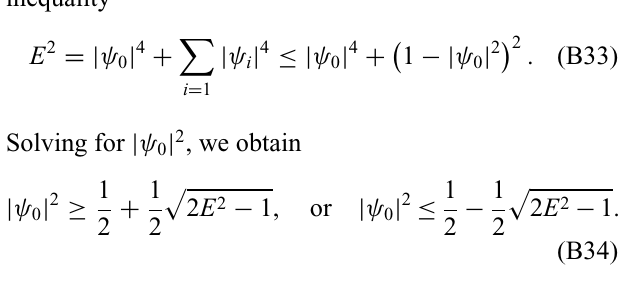
FIG. 19. The number of iter- ations required for this explicit instance. The optimizer algorithm is L-BFGS-B without any further adjustments. Very good results are already obtained after three itera- tions and fewer than 25 ground- state overlap evaluations. The data correspond to the first eight itera- tions of an instance of the black- box optimizer with five chunks for fixed total time T = 1 and N = 100.